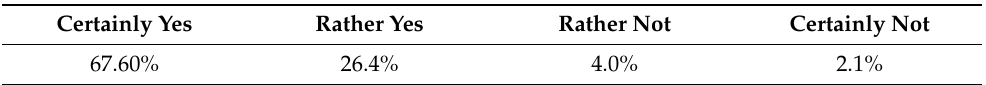
Table 3. Responses regarding the existence of climate change. Q: Is it true, from your point of view, that we are currently facing climate changes? Certainly Yes Rather Yes Rather Not Certainly Not 67.60% 26.4%